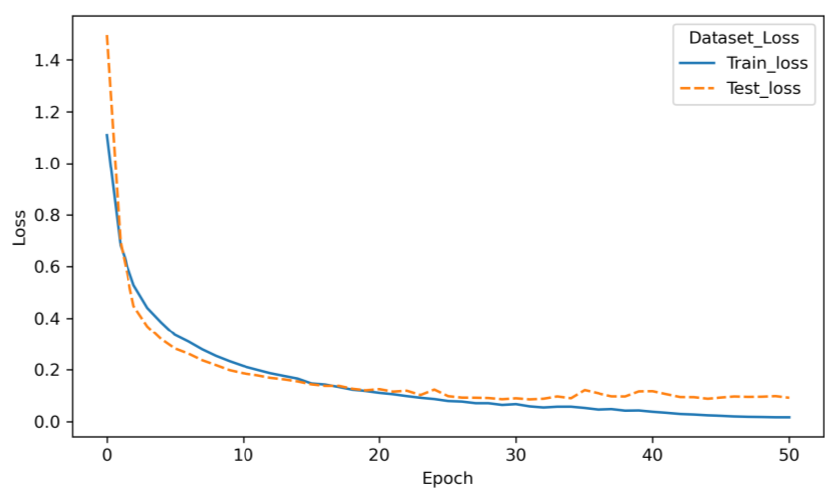
Figure 7. The 1D-RCNN training process loss function.